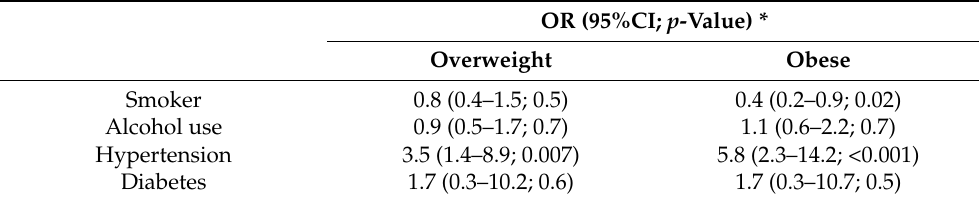
Table 3. Association of cardiovascular risk factors by BMI category for bus drivers determined using logistic regression